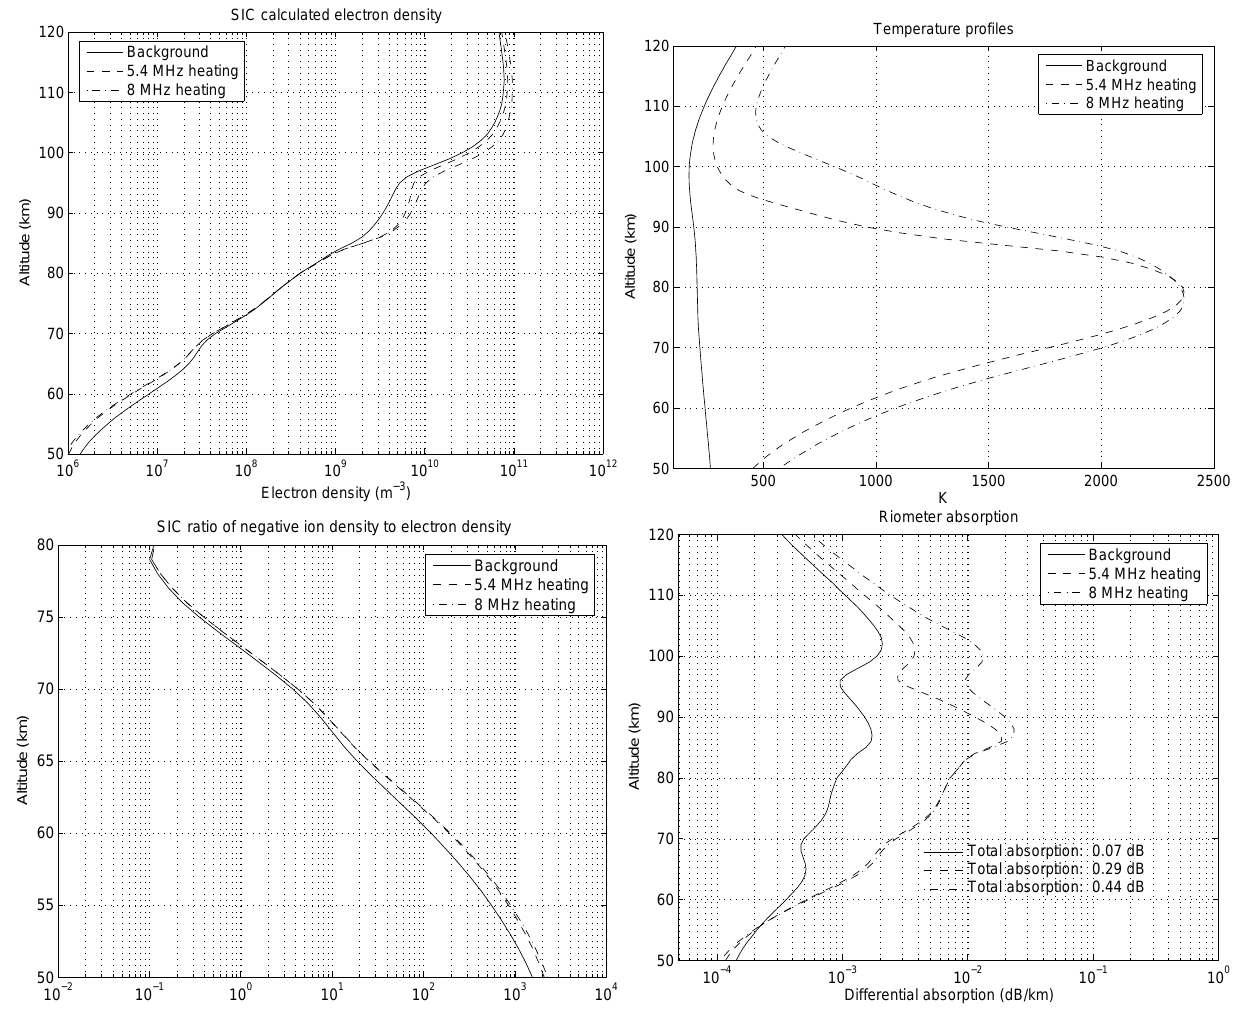
Fig. 3. The quiet-day noon case, altitude profiles at the end of the heating interval (12:55 UT) for the background run and the two heating cases of 0.6GW ERP at 5.4MHz and 1.2GW ERP at 8 MHz. Plot 1: SIC modelled electron density; Plot 2: Electron temperatures; Plot 3: The ratio of negative ion density to electron density (NOTE: this is only shown for altitudes up to 80km); Plot 4: The calculated cosmic noise absorption at 38.2MHz as observed by a narrow riometer beam tilted by 45 ◦